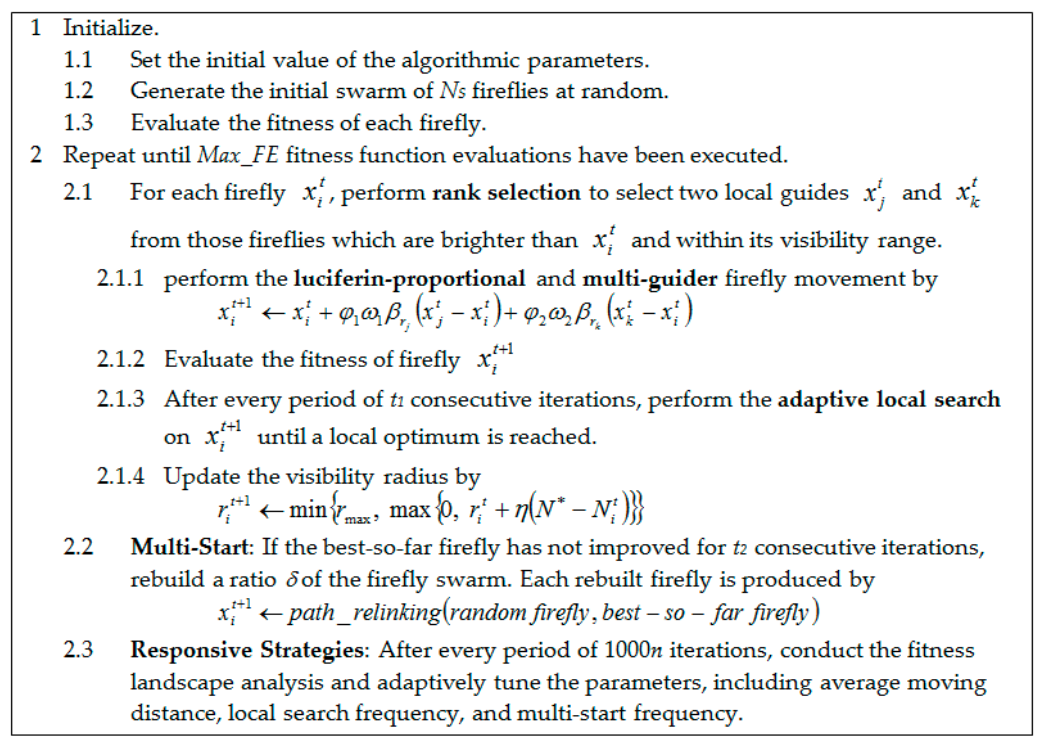
Figure 1. Pseudo ‐ code of the CFA algorithm. Figure 1. Pseudo-code of the CFA